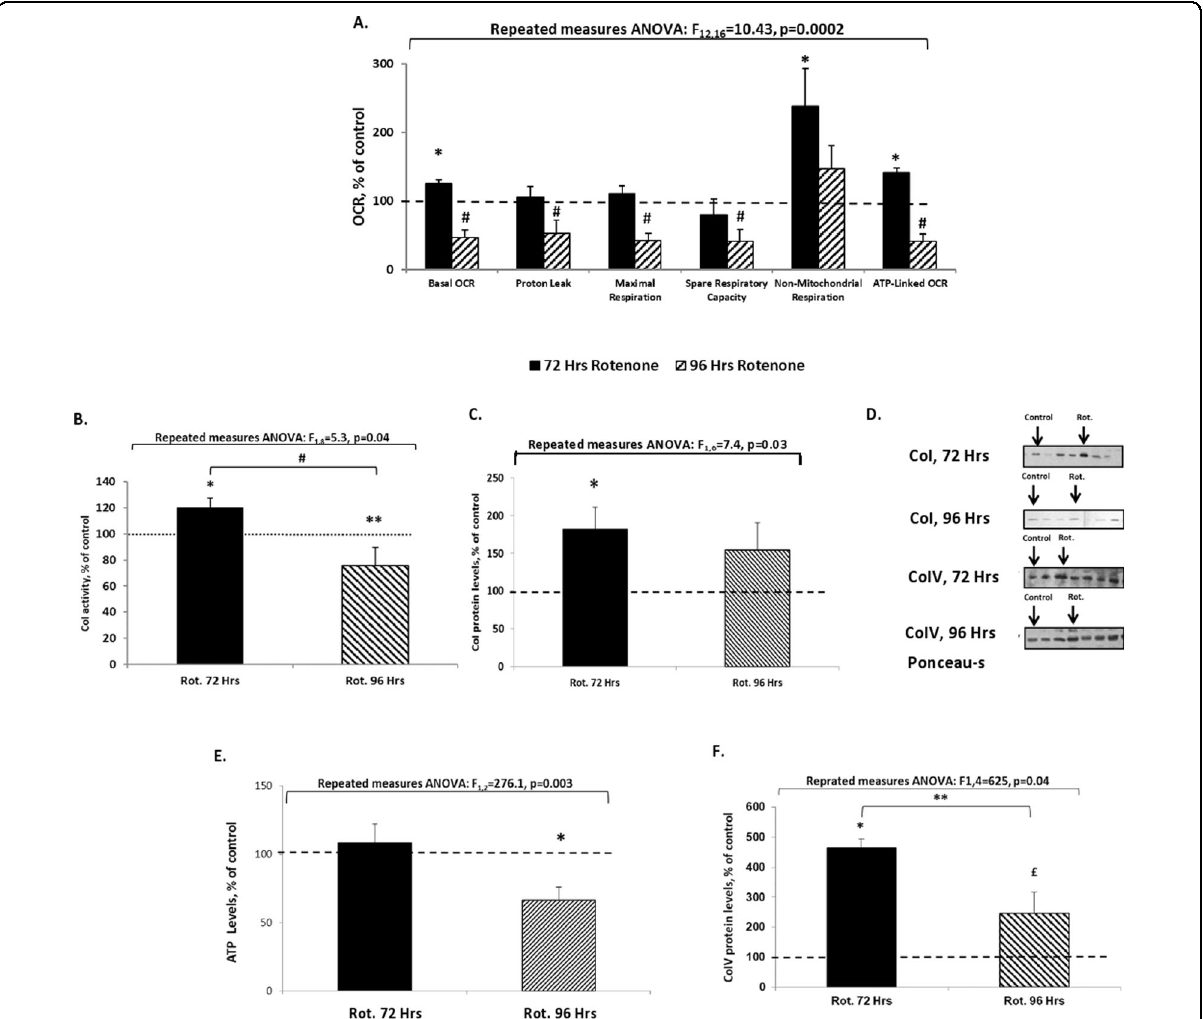
Fig. 2 Mitochondrial function-related parameters following exposure to 10 pM rotenone for 72 and for 96 h. Results expressed in percentage of control (vehicle-treated) represent means ± SEM of at least four independent experiments, each in triplicate. A Respiration parameters. Results in pmoles O 2 consumed/min/mg protein (converted into % of control) of four independent experiments, each point in duplicate. Control values were: Basal OCR – 8.35 ± 2.02; Proton leak – 1.79 ± 0.25; Maximal respiration – 18.04 ± 6.90; Spare capacity – 9.70 ± 2.85; Non-mitochondrial OCR – 2.19 ± 1.57; ATP-linked OCR – 6.55 ± 1.77. Two results exceeding ±2SDs were excluded. Fisher ’ s LSD post hoc test revealed that exposure to 10 pM rotenone for 72 h resulted in signi fi cant upregulation of basal OCR, non-mitochondrial respiration, and ATP-linked OCR, p < 0.05, while exposure to this concentration for 96 h led to a signi fi cant downregulation of all respiration parameters except for non-mitochondrial OCR, p < 0.04. B – D Complex I activity and protein levels. Results of fi ve independent experiments, each in triplicate. B Complex I activity. Control value was: 98 ± 39 OD 540nm . Exposure to 10 pM rotenone (Rot.) signi fi cantly enhanced and decreased CoI activity following 72 and 96 h, respectively. Fisher ’ s LSD post hoc test: # 72 h vs . 96 h of exposure, p = 0.01; *one-tailed post hoc Fisher ’ s LSD test: 72 h vs . control, p = 0.05; **one-tailed post hoc Fisher ’ s LSD test: 96 h vs . control, p = 0.02. C Complex I protein levels. Control value was: 2.8 ± 0.6 arbitrary units (a.u.). Fisher ’ s LSD post hoc test: *exposure for 72 h demonstrated a signi fi cant increase vs. control, p = 0.02. D Representative blots of CoI protein bands and Ponceau-S (total protein, for normalization). E ATP levels. Results of four independent experiments, each in triplicate, obtained in a.u. and converted into % of control. Control value was: 7.2 ± 2.2 a.u. Exposure to 10 pM Rot. for 96 h signi fi cantly decreased ATP levels. Fisher ’ s LSD post hoc test: *96 h vs . control, p < 0.05. F Complex IV protein levels. Results of fi ve independent experiments, each in triplicate. The control value was: 4.2 ± 1.6 a.u. Exposure to 10 pM Rot. for 72 h and for 96 h signi fi cantly increased complex IV protein levels. Fisher ’ s LSD post hoc test: *72 h Rot. vs . control, p = 0.00001; £ 96 h Rot. vs. control, p = 0.001; **72 vs. 96 h of Rot. vs. control, p =